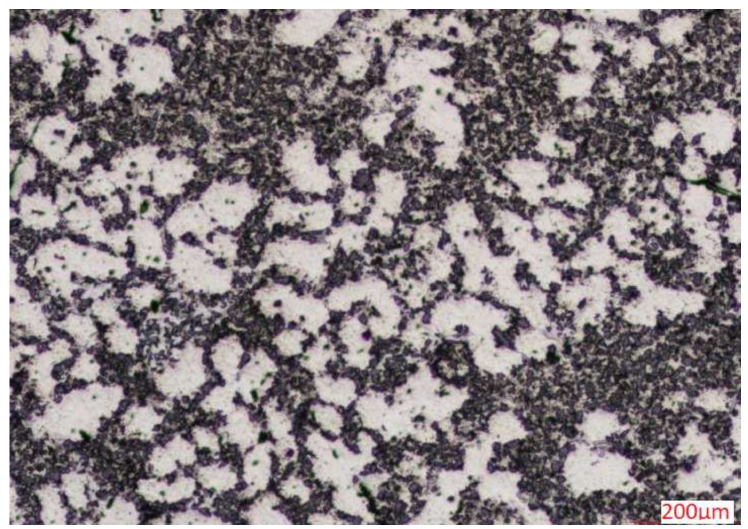
Figure 8. Photomicrograph of the core microstructure of Disc 2